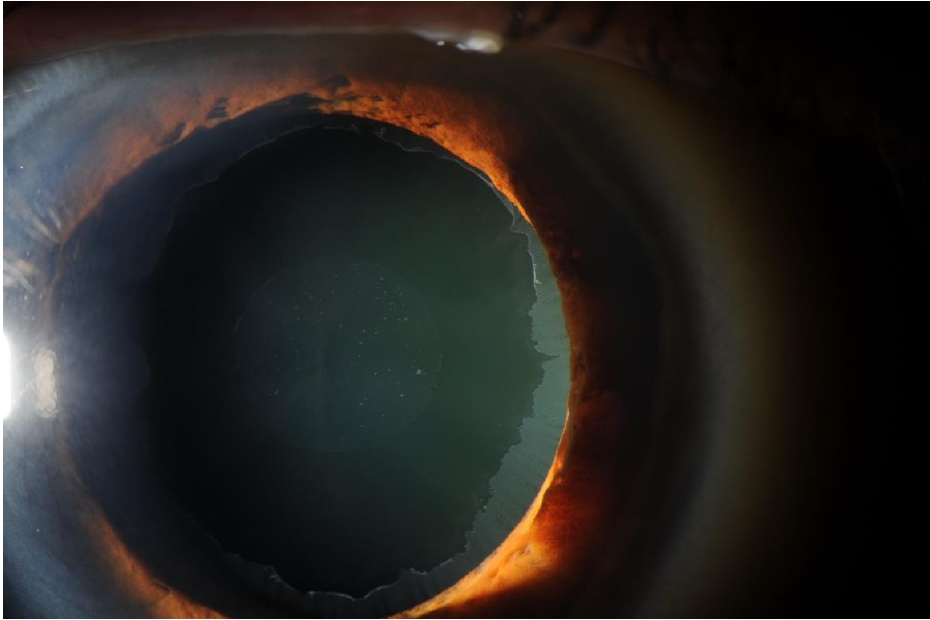
Figure 1. Image of the anterior segment of an eye with XFS.